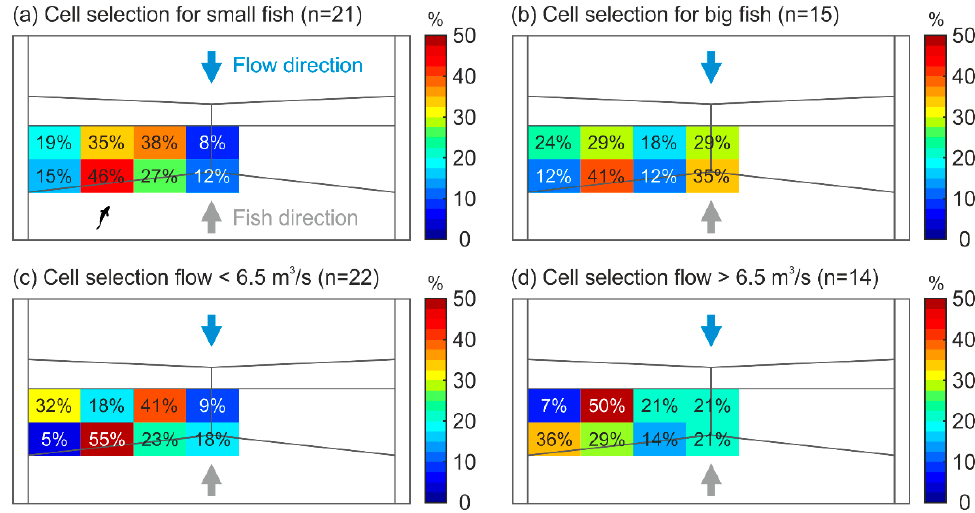
Figure 6. Frequency distributions of fish entry (downstream) and exit (upstream) cells by size ( a , b ) and flow rate ( c , d ). Due to the symmetrical nature of flat-V weirs and the lower quality of images in the left bank of the weir, only the half of the flat-V weir closest to the camera bank was analyzed. In total, 47% of recorded fish (17/36) changed section while ascending (i.e., upstream